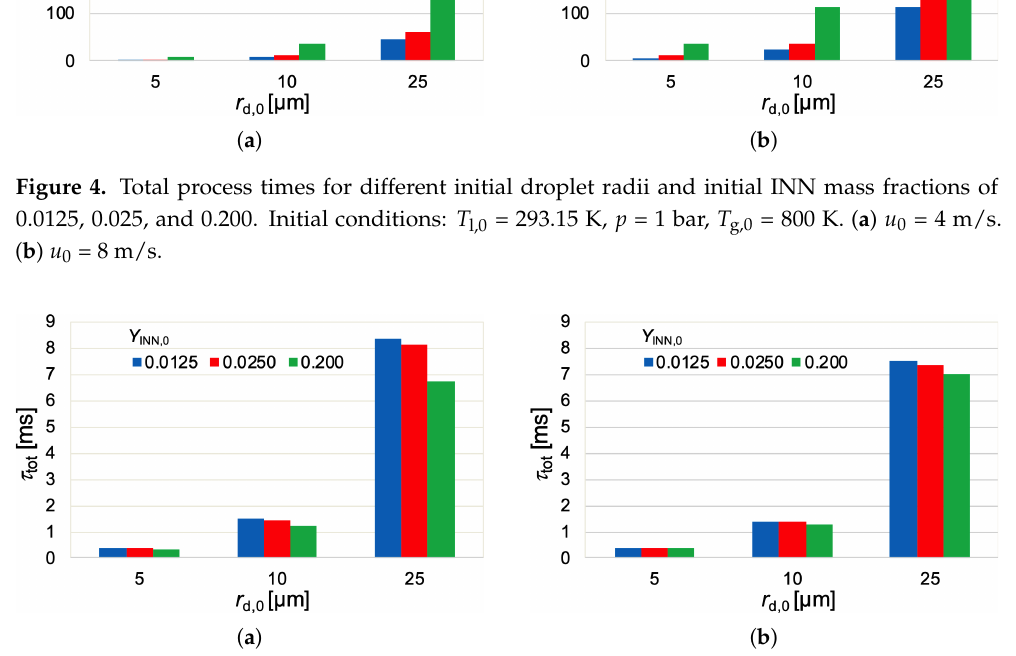
Figure 5. Total process times for different initial droplet radii and initial INN mass fractions of 0.0125, 0.025, and 0.200. Initial conditions: T l,0 = 293.15 K, p = 1 bar, T g,0 = 1200 K. ( a ) u 0 = 4 m/s. ( b ) u 0 = 8 m/s.